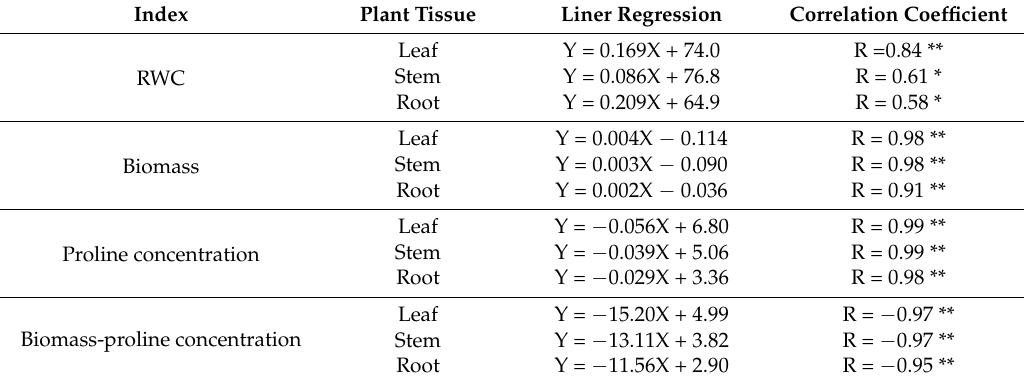
Figure 4. Relationship between average soil water content (% pot capacity (PC)) and ( a ) relative water content (RWC), ( b ) biomass, ( c ) proline concentration and ( d ) the relationship between biomass and proline concentration in the leaves, stems and roots of lucerne seedlings. The linear regressions and correlation coefficients are shown in Table 3. Table 3. The linear regressions and correlation coefficients between the average soil water content (% pot capacity (PC)) and relative water content (RWC), biomass and proline concentration, and the relationship between biomass and proline concentration in the leaves, stems and roots of lucerne